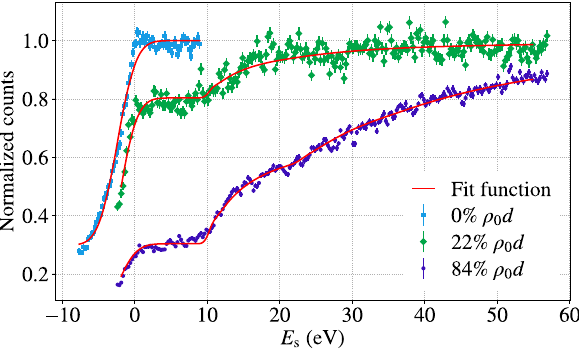
Fig. 7 Background measurements of the electron gun with the light source turned off at different fractions of the nominal column density ρ 0 d . Background electrons generated on the emission electrode of the electron gun show similar energy and column density dependencies as signal electrons. Compared to signal electrons, the background energy distribution is broader and shifted towards higher initial values. A com- bined fit to the data (red line) is used to determine the mean position m Bg andthe width w Bg of theinitialenergy distribution. For betterillus- tration, the shown data is normalized such that the region of unscattered electrons in the plateau at E s ∈ [0eV , 8eV] equals P 0